Question: Draft a figure caption describing what is shown.
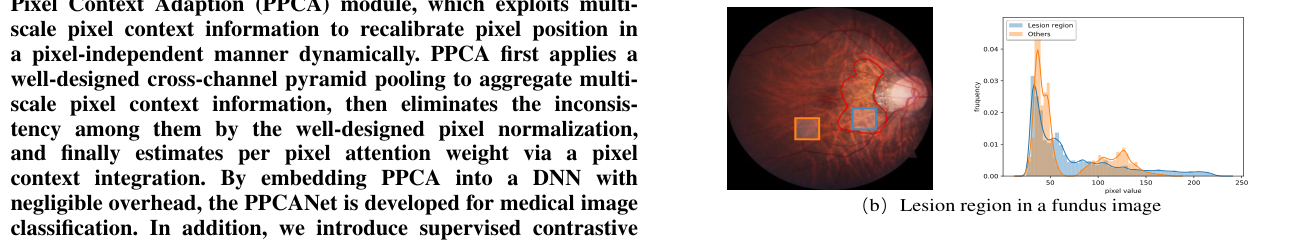
Answer: (a) Object region in a natural image, which is salient through observing pixel value distribution difference between object region and other regions. (b) The subtle lesion region of myopia on the fundus image. We also present a pixel value distribution comparison between a subtle lesion region and a redundant region.